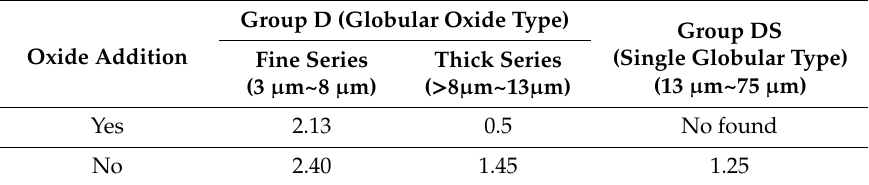
Figure 7. Inclusion distribution in the steels before ( b ) and after ( a ) oxide addition. Table 2. Evaluated inclusion grade in the steels based on Figure 7. Oxide Addition